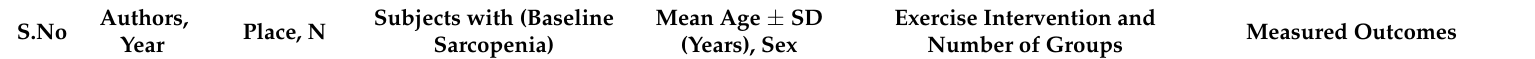
Table 1. Effect of exercise on subjects with cancer and baseline measurement of sarcopenia.